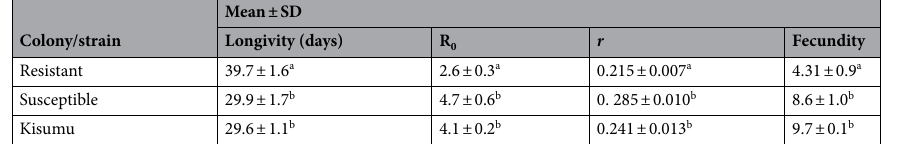
Table 2. Comparison of adult longevity, fecundity, net reproductive rate and intrinsic growth rate among the resistant, susceptible and Kisumu colonies. Fecundity is measured in number of female progeny per female per day. R 0—is the mean net replacement rate (number of offspring per female per generation). r— is intrinsic per-capita growth rate (number of offspring per female per day). *Mean and standard deviations of fecundity, net reproductive rate intrinsic per-capita growth rate and survival time. The same superscript letters indicate no significant difference.